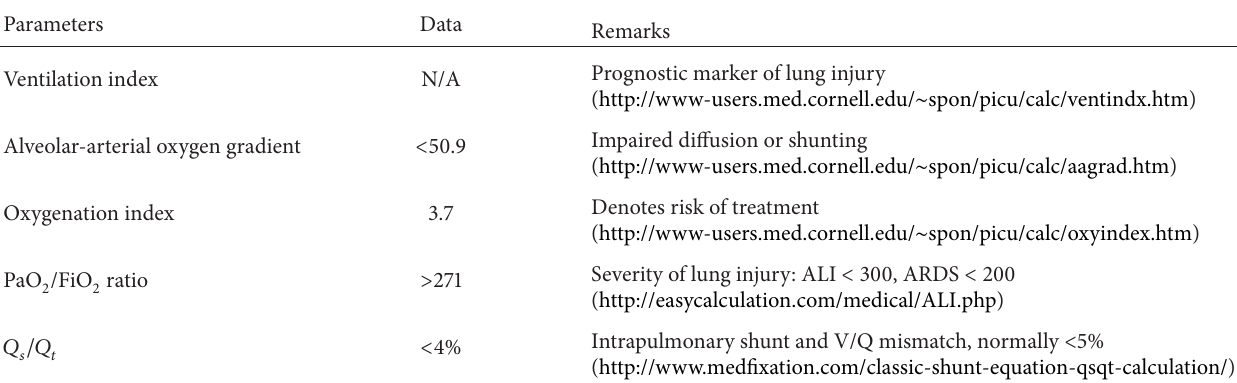
Table 1: Respiratory indices.